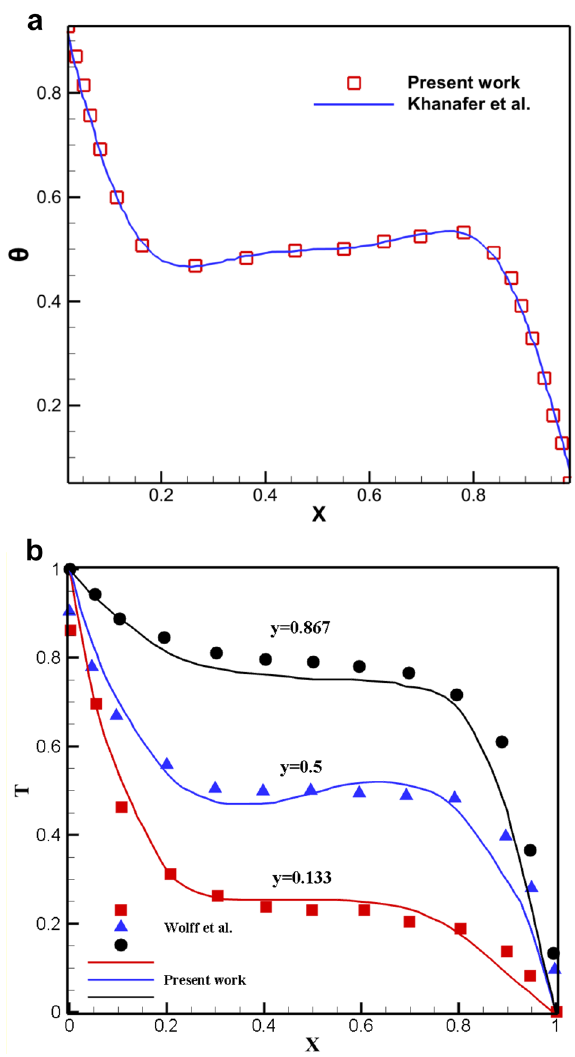
Figure 5. (a) Validation of the present study with Khanfar et al. 43 . φ = 0.05 and Pr = 6.2 (Cu–Water). ( b ) Validation of the present study with the experimental work of Wolff et al. 44 . Z = 0.5, Ra = 1.689 × 10 5